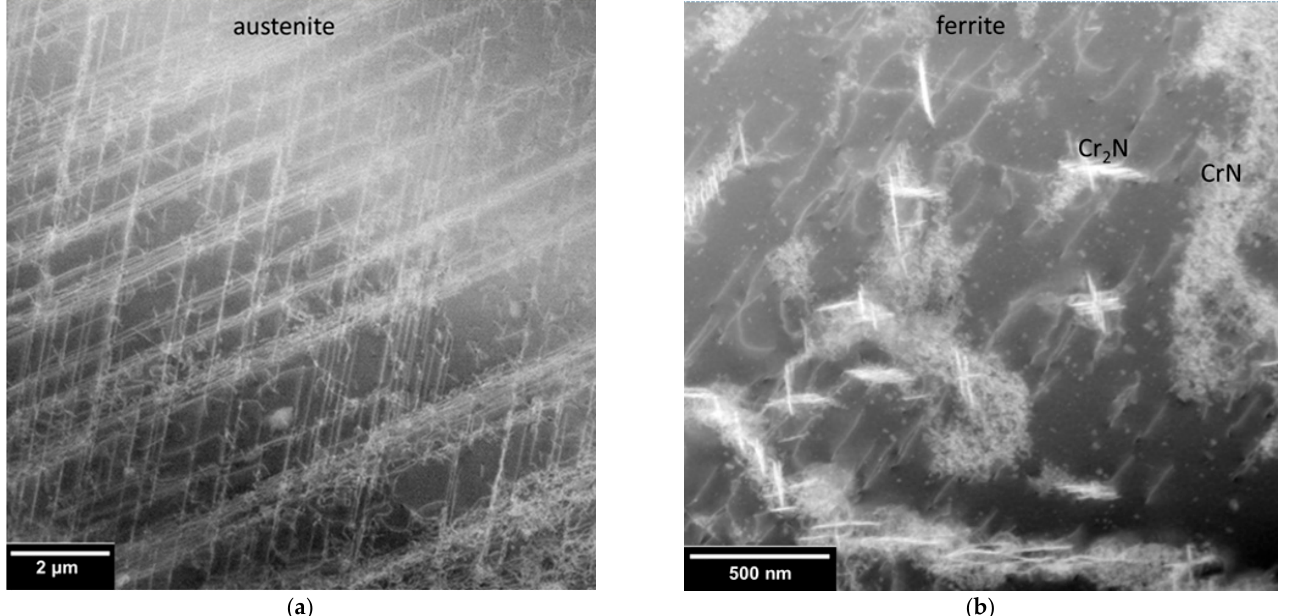
Figure A2. Detailed STEM images of the dislocation arrangement in an austenitic ( a ) and a ferritic grain ( b ) after isothermal fatigue at 20 °C.